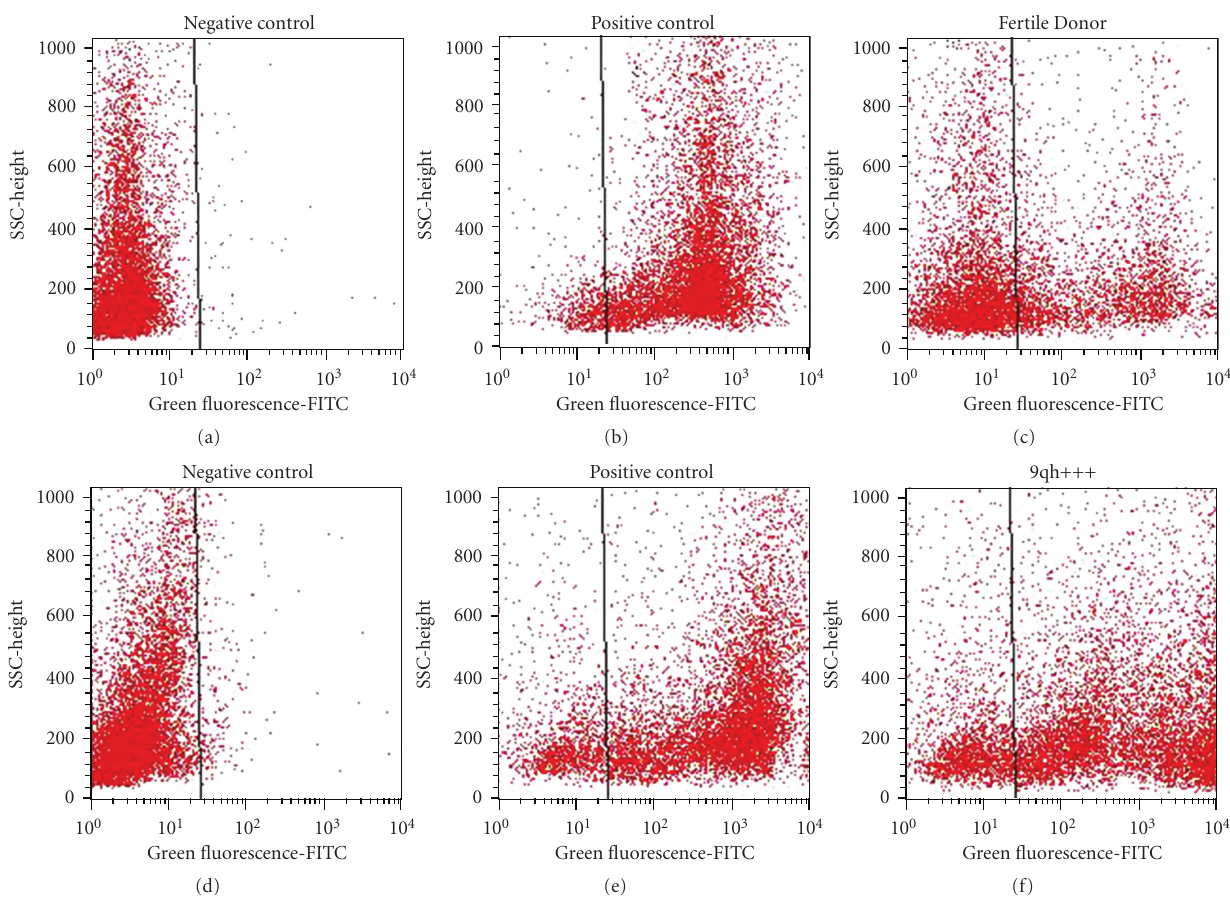
Figure 2: Cytogram for TUNEL. (a, d) The negative control was incubated without the TdT enzyme. (b, e) Positive control was prepared before the labeling reaction with an additional treatment with DNAse I. (c, f) The TUNEL-positive cell in the fertile donor and patient sample was measured, respectively, with respect to the negative-control sperm population using a 530nm ± 30 nm band-pass filter. A total of 10 000 events were measured at a flow rate of 200–300cells/s on a flow